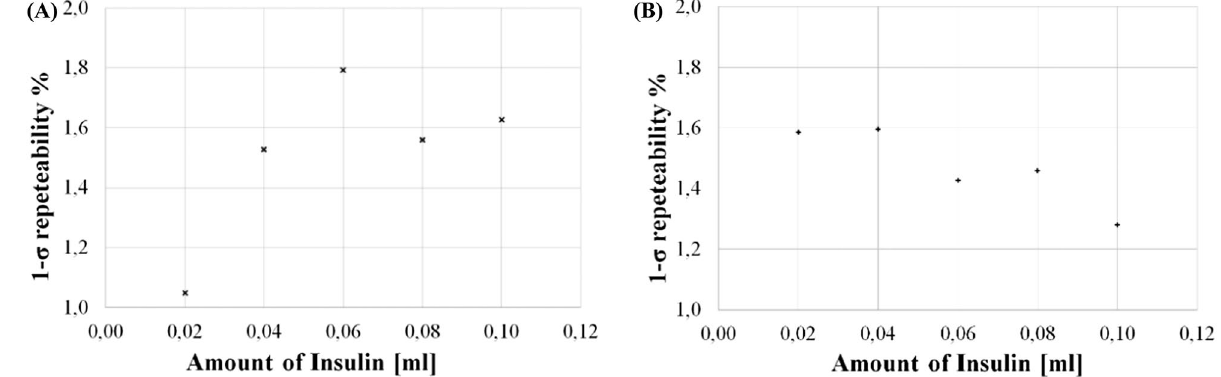
Figure 6. 1-σ-repeatability versus amount of injected drug in in-vitro ( A ) and ex-vivo ( B )